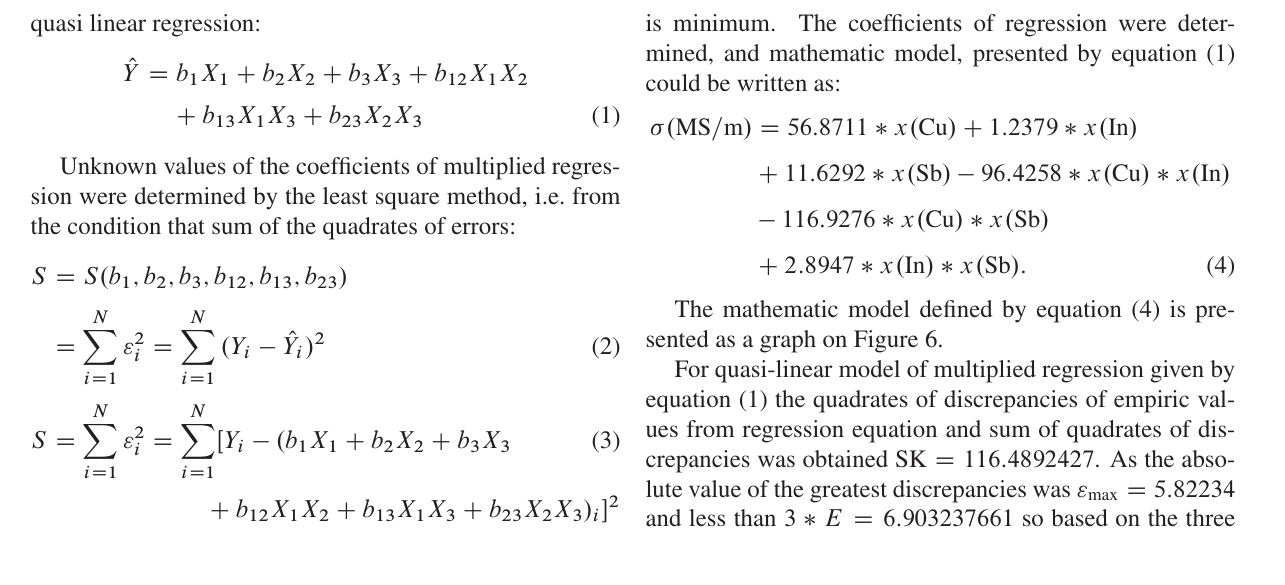
Figure 2. Microstructures of alloys of Cu-In-Sb ternary system, 800 (cid:2) . quasi linear